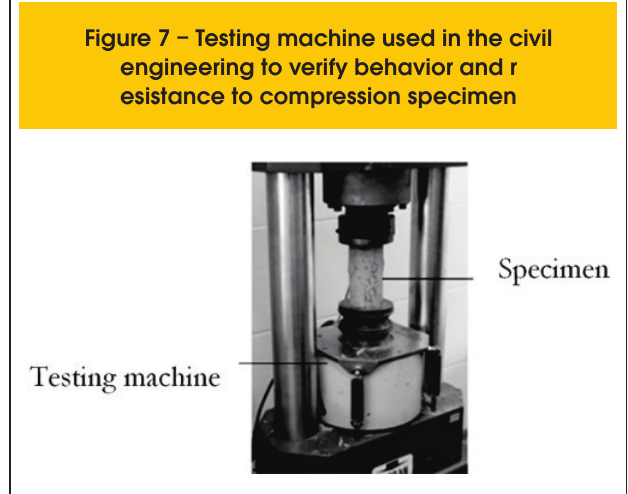
Figure 7 – Testing machine used in the